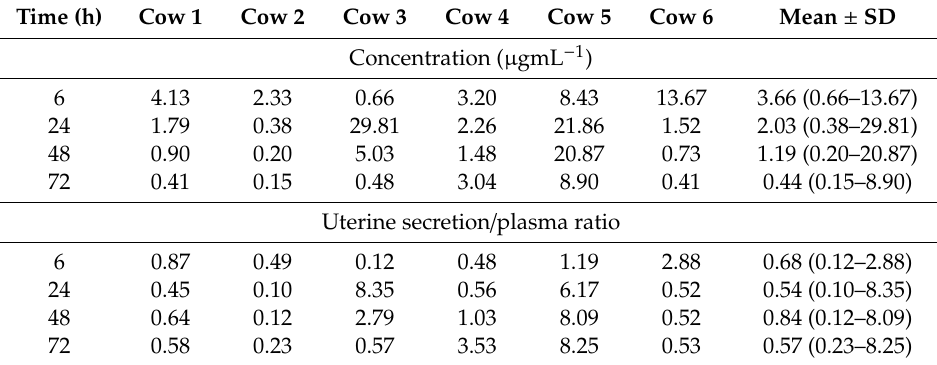
Table 3. Oxytetracycline concentrations in uterine secretion in cows ( n = 6) with clinical metritis (Median and range in the parenthesis) and uterine secretion / plasma ratio after single